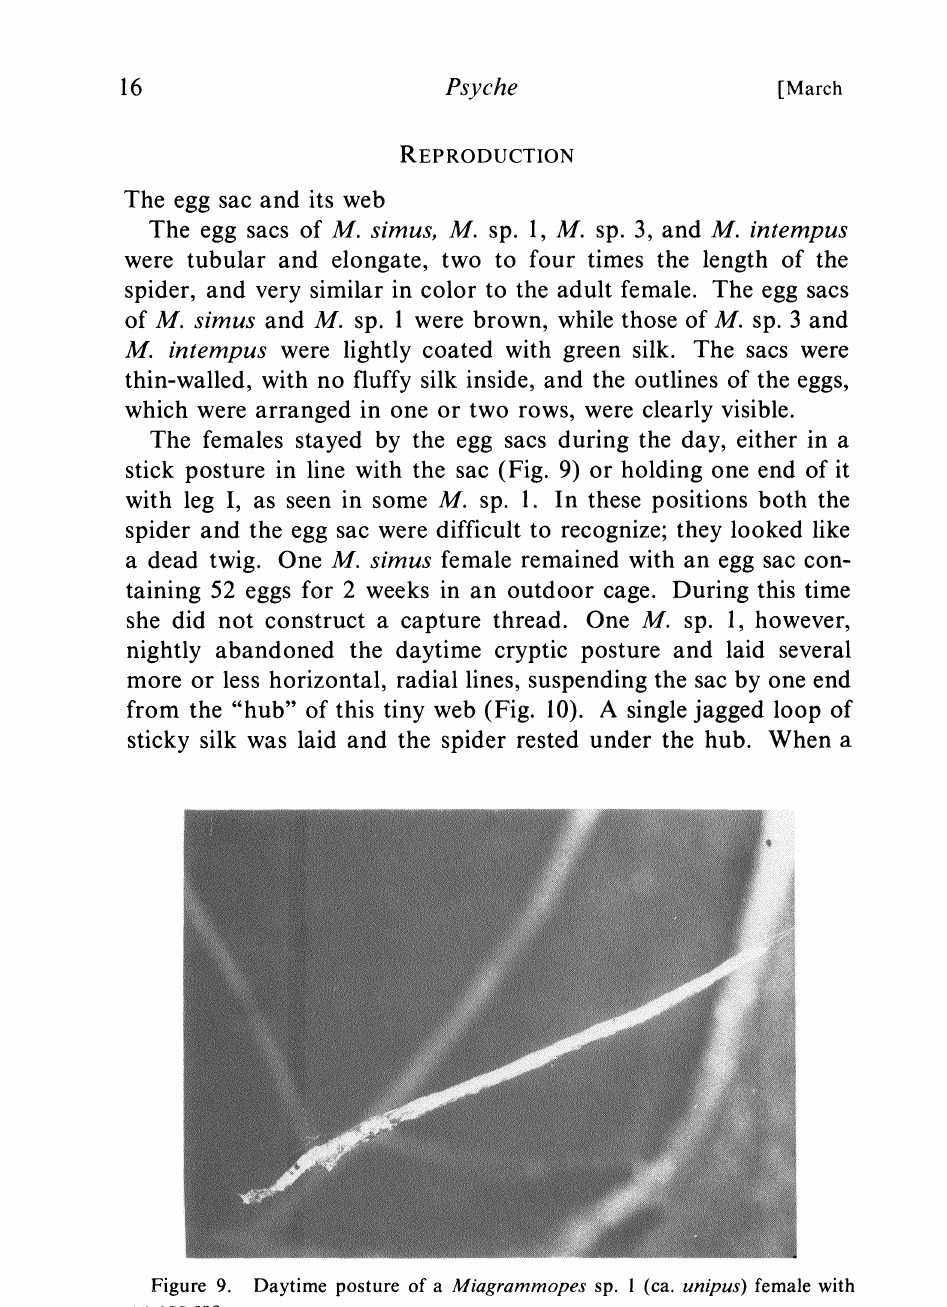
Figure 9. Daytime posture of a Miagrammopes sp. (ca. unipus) female with an egg